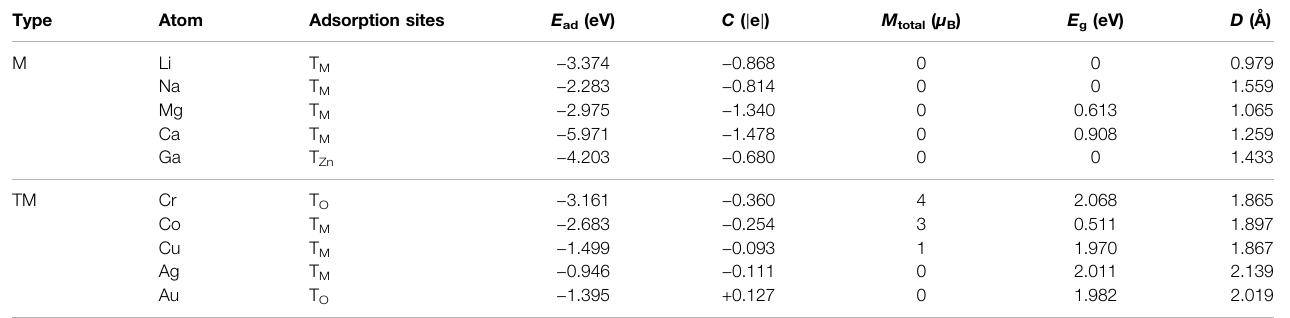
TABLE 1 | The adsorption energy ( E ad ), charge transfer ( C ), magnetic moment ( M total ), bandgap ( E g ), and adsorption height ( D ) of the M or TM absorbed g-ZnO systems. Type